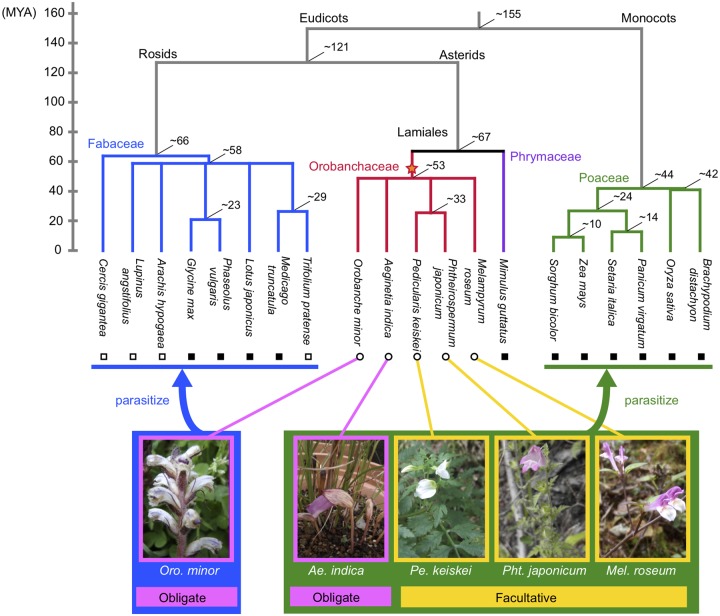
—Overview of the phylogenetic relationship of the five Orobanchaceous parasite species and their potential host species. The speciation times in million years (numbers at nodes) are according to TimeTree (Hedges et al. 2006; Hedges et al. 2015; http://www.timetree.org; last accessed November 6, 2018). The star indicates the origin of parasitism. The open circles are for the five parasite species, for which we sequenced in this study. The filled and open squares, respectively, represent species having full reference genome with annotated CDS information and those having transcriptome shotgun assemblies (TSA) data. See supplementary table S3, Supplementary Material online for the summary of the data used in this study.